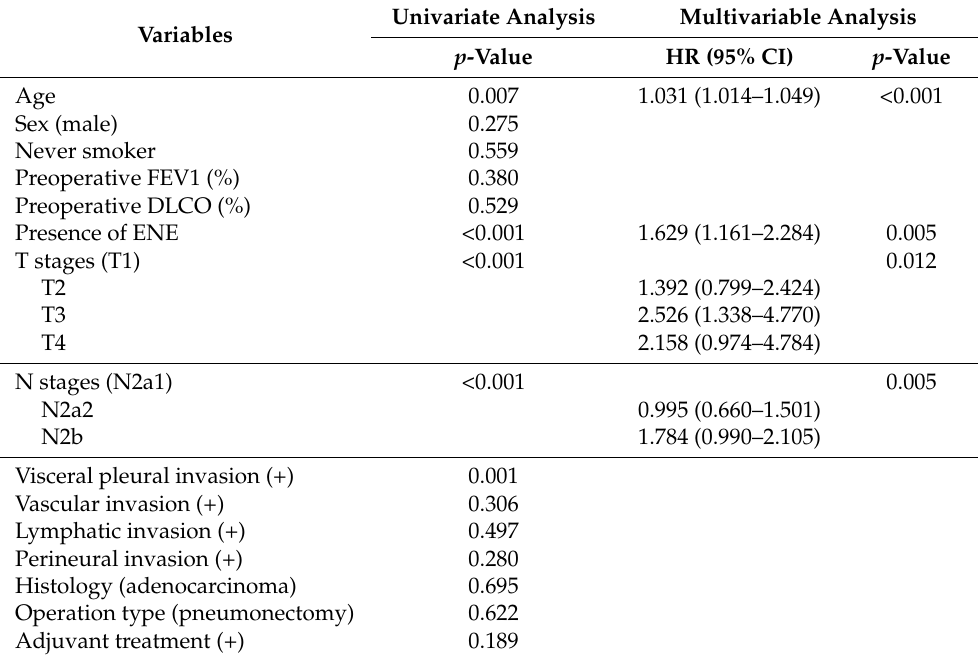
Table 2. Prognostic factors affecting disease free survival.